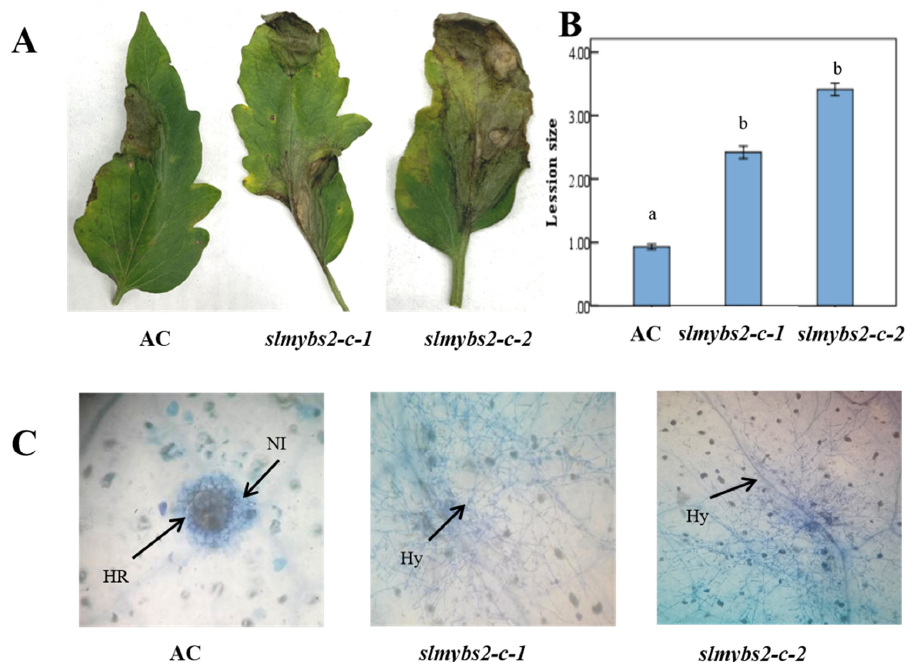
Figure 4. Knocking out SlMYBS2 reduced the resistance to P. infestans . Infiltration of slmybs2-c- and AC plants with P. infestans. ( A – C ) Parameters showing the extent of the disease five days after infection with P. infestans . ( A ) Disease symptoms; ( B ) lesion size (cm); ( C ) number of necrotic cells (scale bars: 100 μ m). Hy, hyphae; Nl, necrotic lesions; HR, hypersensitive response. Different lowercase letters indicating significant differences at the 0.05 level.